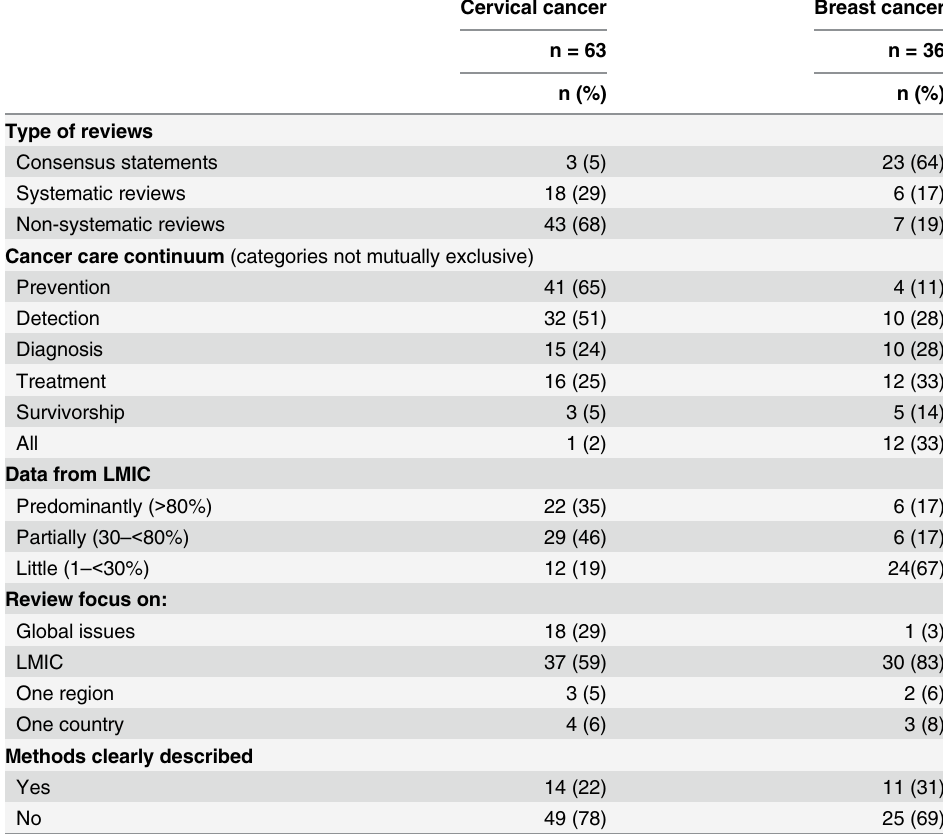
Table 2. Descriptive summary of breast and cervical cancer reviews in low- and middle-income coun- tries